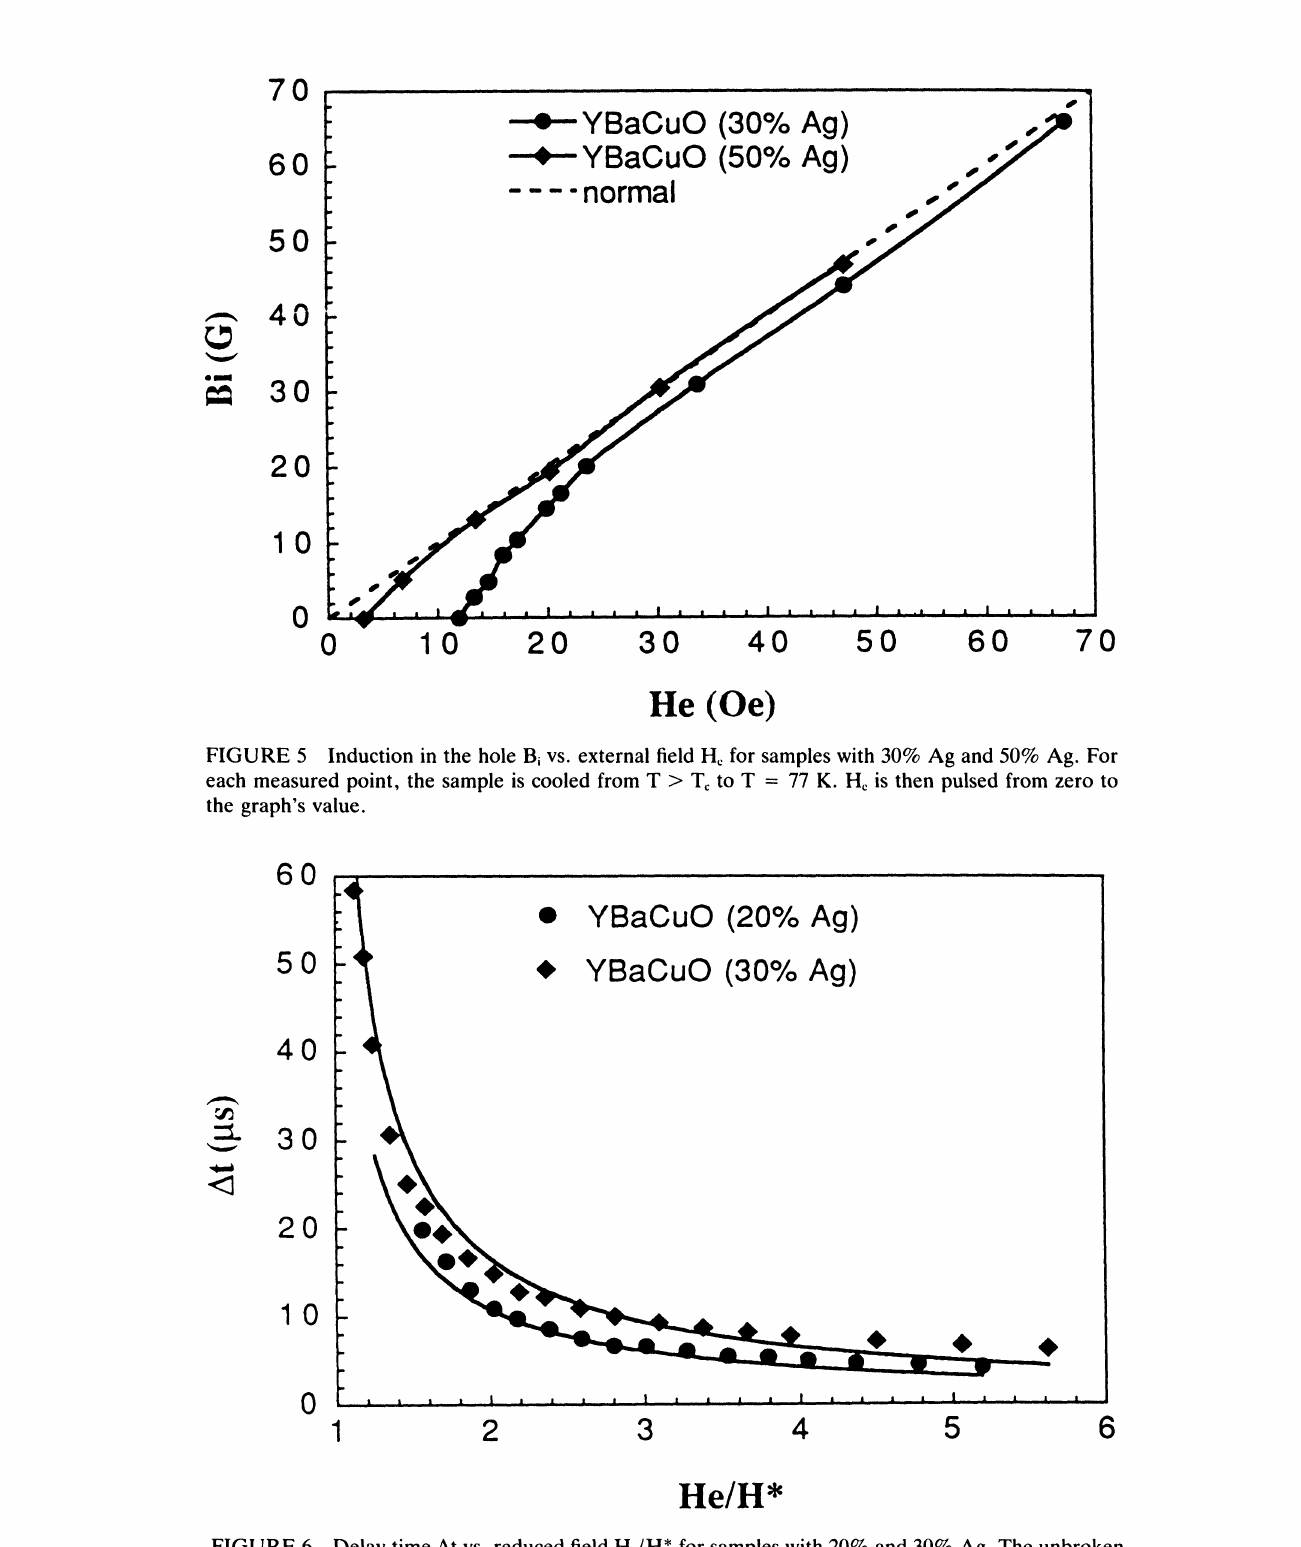
FIGURE 6 Delay time At vs. reduced field He/H* for samples with 20% and 30% Ag. The unbroken lines are a fit to eq. (4). T 77